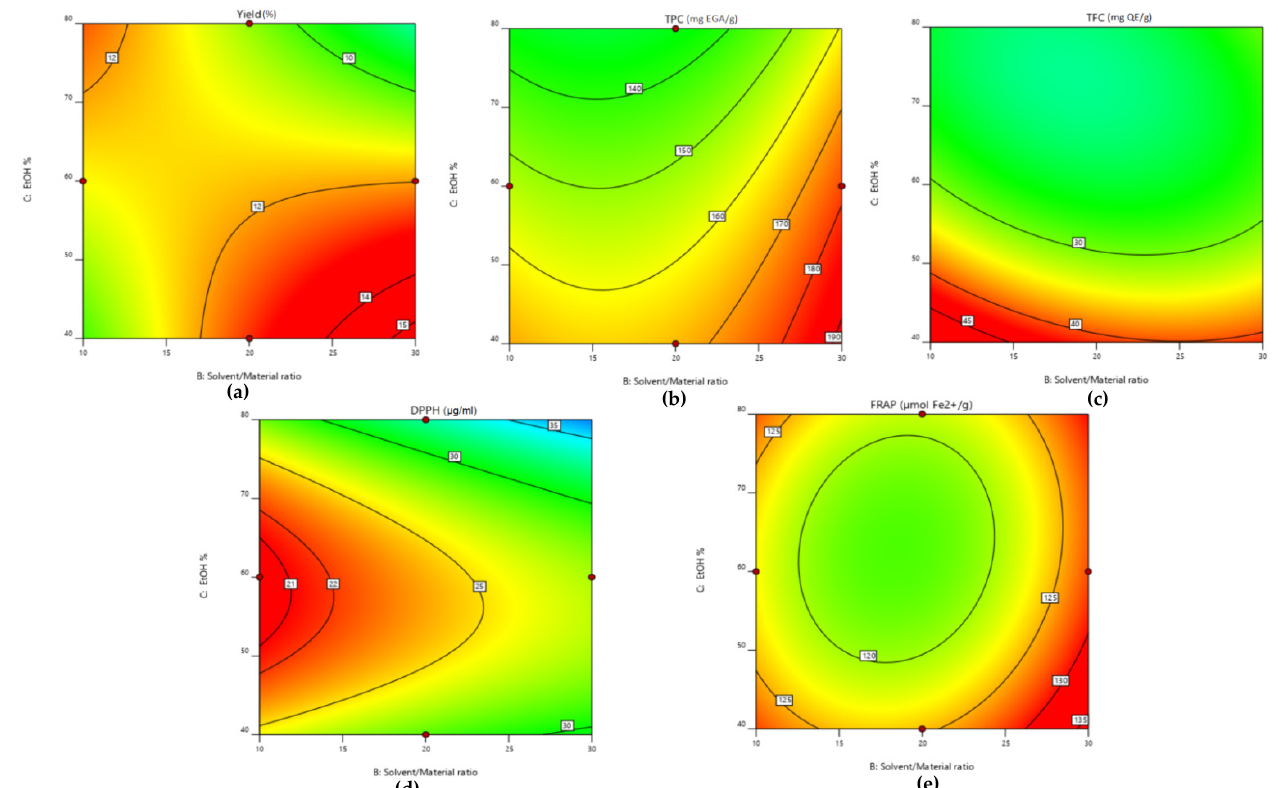
Figure 2. Contour plots for ultrasound-assisted extraction of Moroccan propolis, showing optimal compromise zone leading to the best value of ( a ) yield of extraction, ( b ) total polyphenol content, ( c ) total flavonoid content, ( d ) DPPH-IC 50 , and ( e ) FRAP-EC 50 as a function of solvent/propolis ratio and ethanol concentration and by fixing the sonication time in its optimal value.